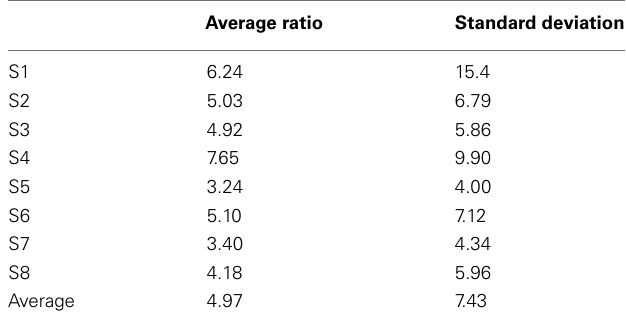
Table 3 | Ratio of the horizontal distance between eyes to the vertical distance from the eyes to the